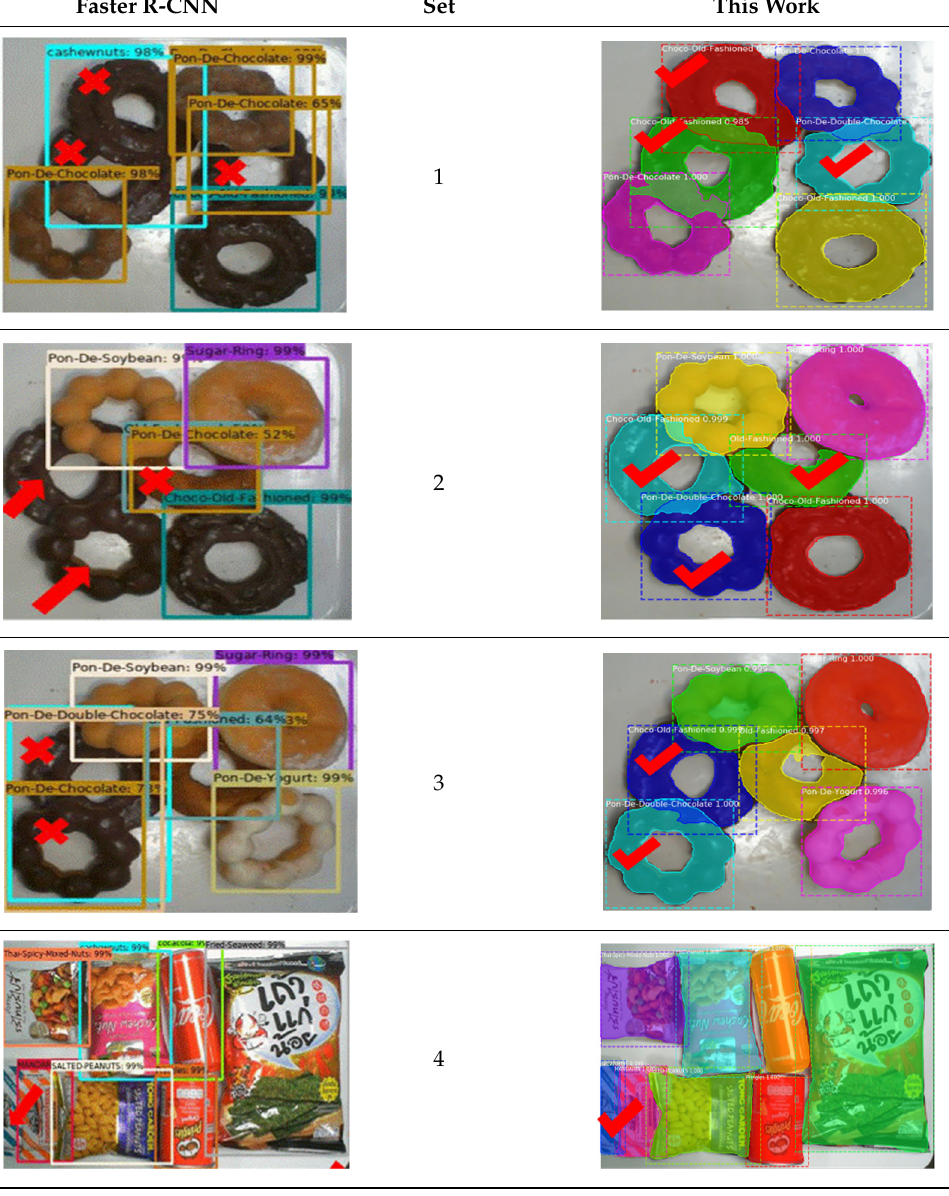
Table 8. Comparison of results. Faster R-CNN Set This